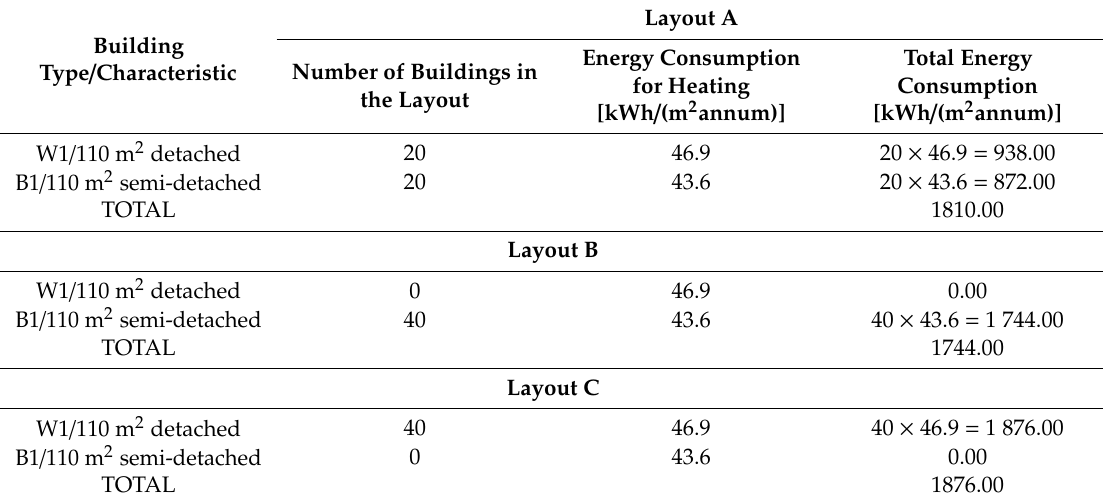
Table 7. Summary for Layouts A, B and C, comprised of 40 buildings